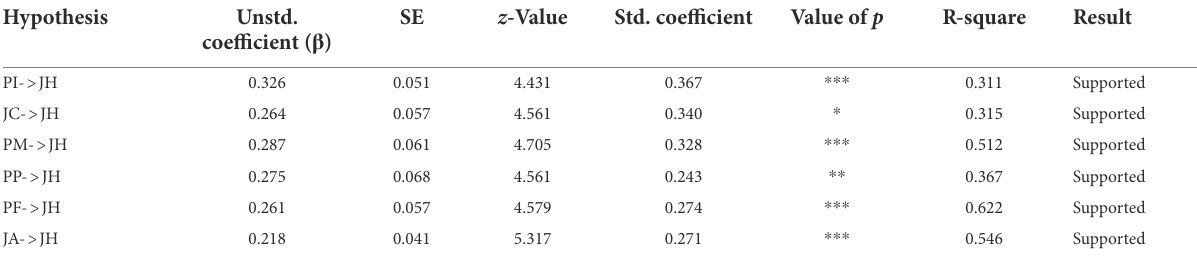
TABLE 5 Regression coefficient.